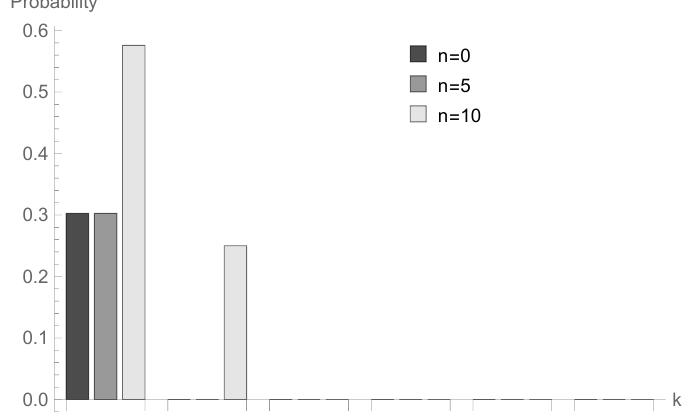
Figure 1. Conditional probabilities (cid:98) ∆ n ( k ) for geometric processing distribution, (cid:36) = 0.75 and n = 0, 5 and 10.